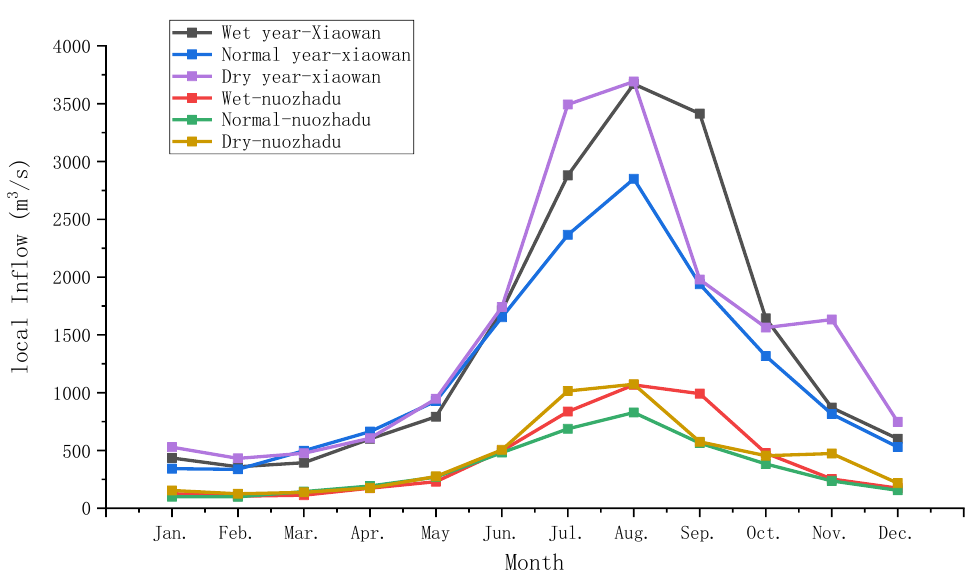
Figure 4. The monthly local inflow of each reservoir in wet, normal and dry years.